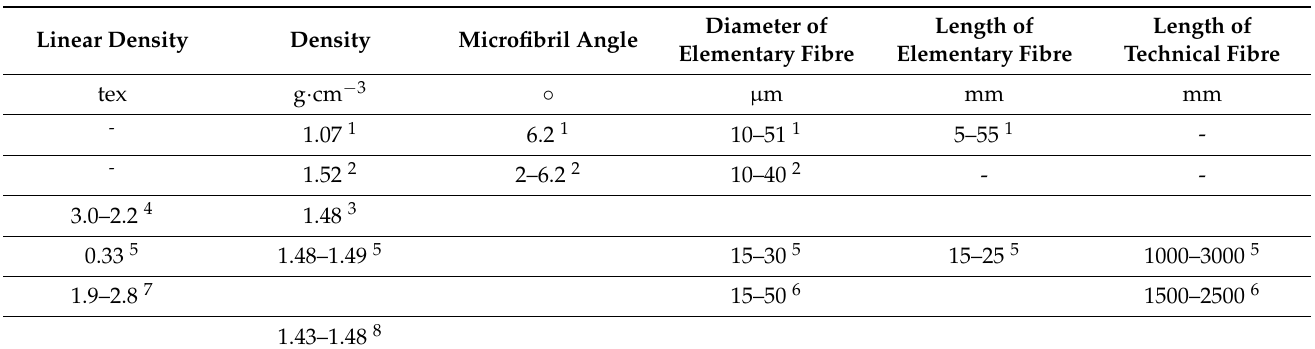
Table 4. Values of mechanical properties of hemp fibres based on data provided by different authors 1